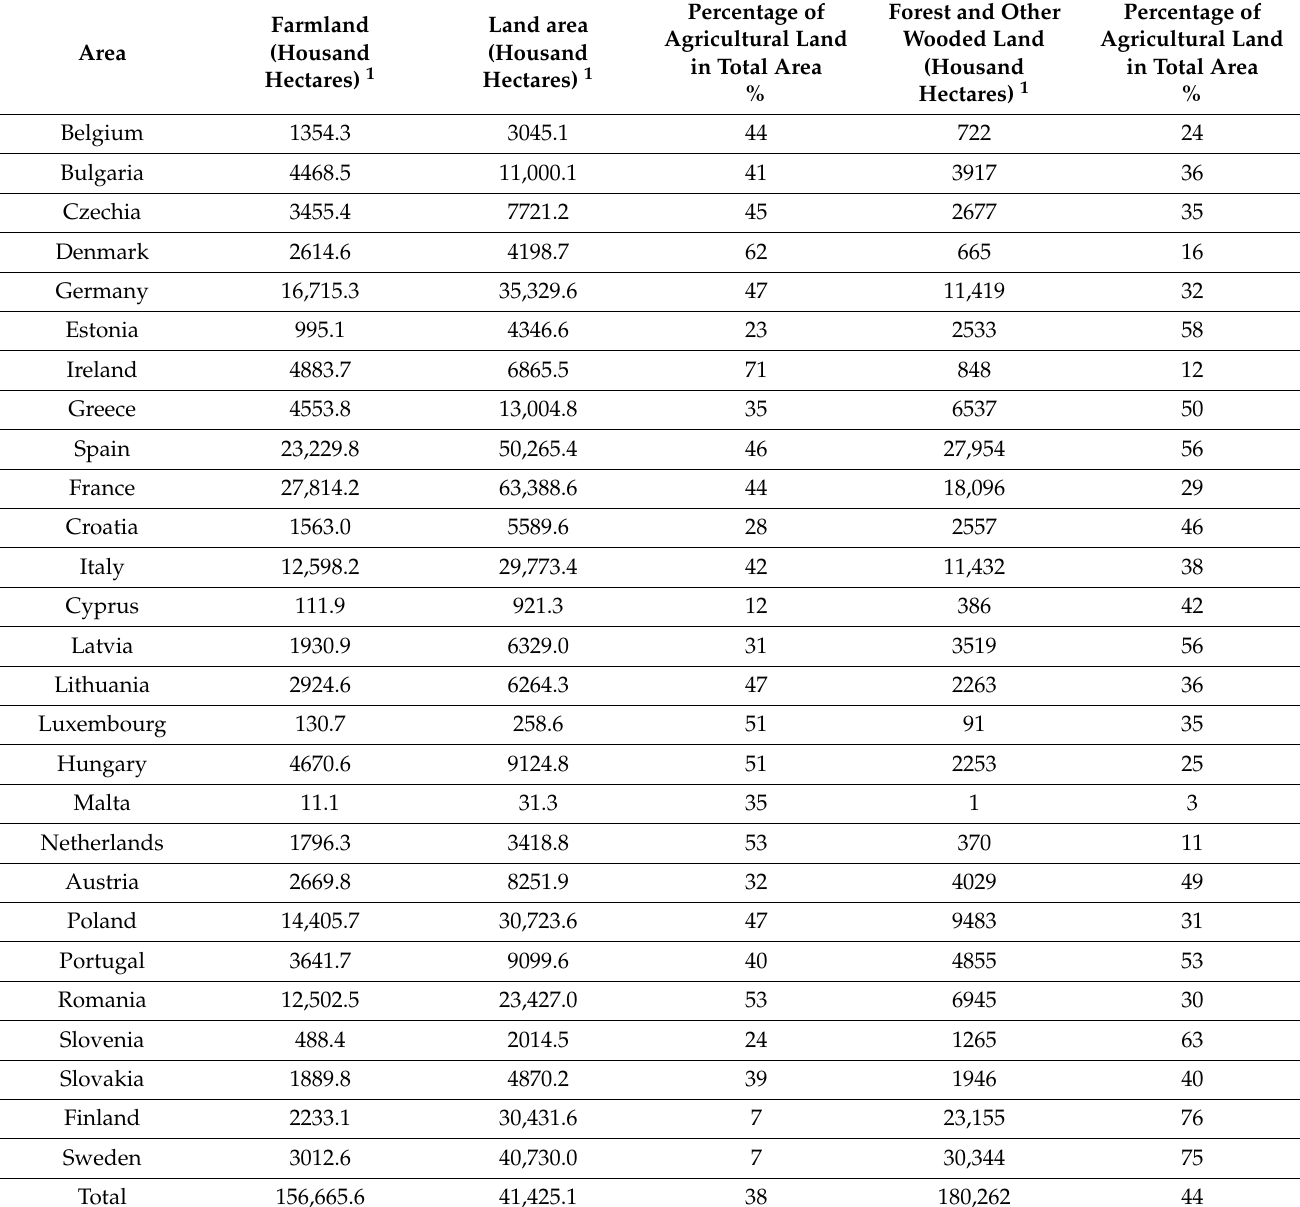
Table 4. The area of agricultural land and forests in the EU member-states in